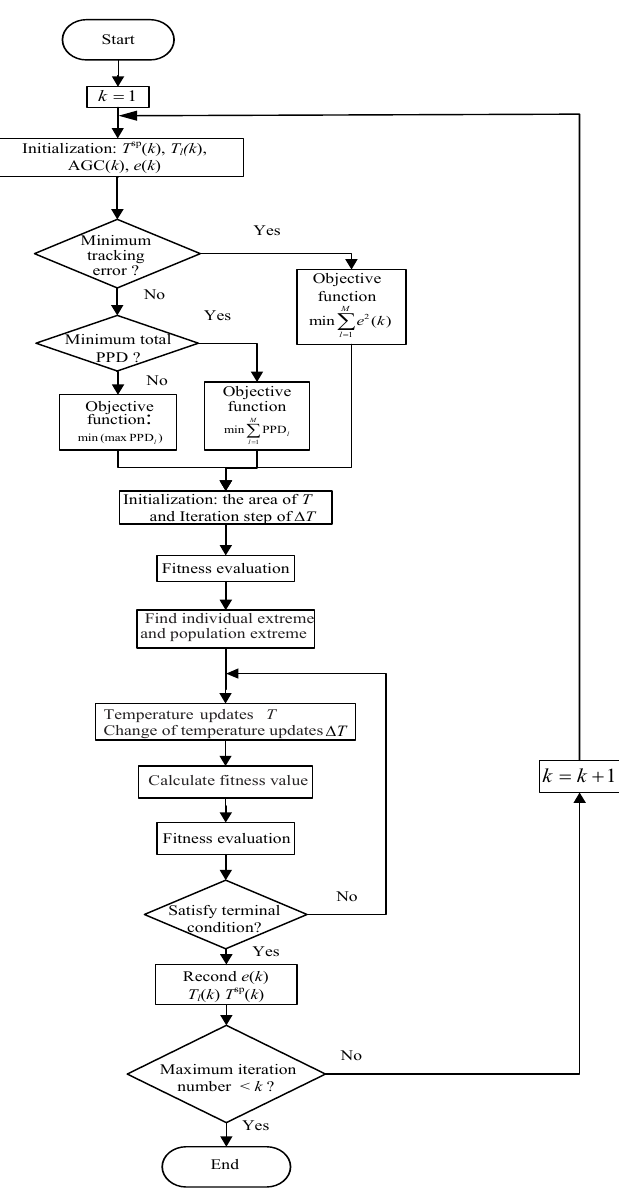
Figure 5. Flow chart of the temperature setpoint optimization algorithm based on active target particle swarm optimization